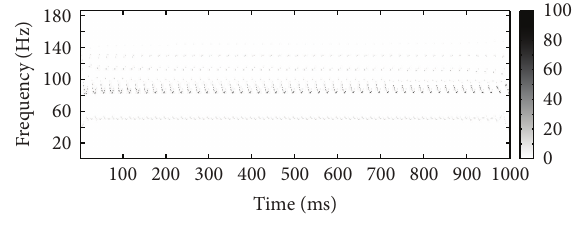
Figure 5: Intensity matrix of Signal 1.